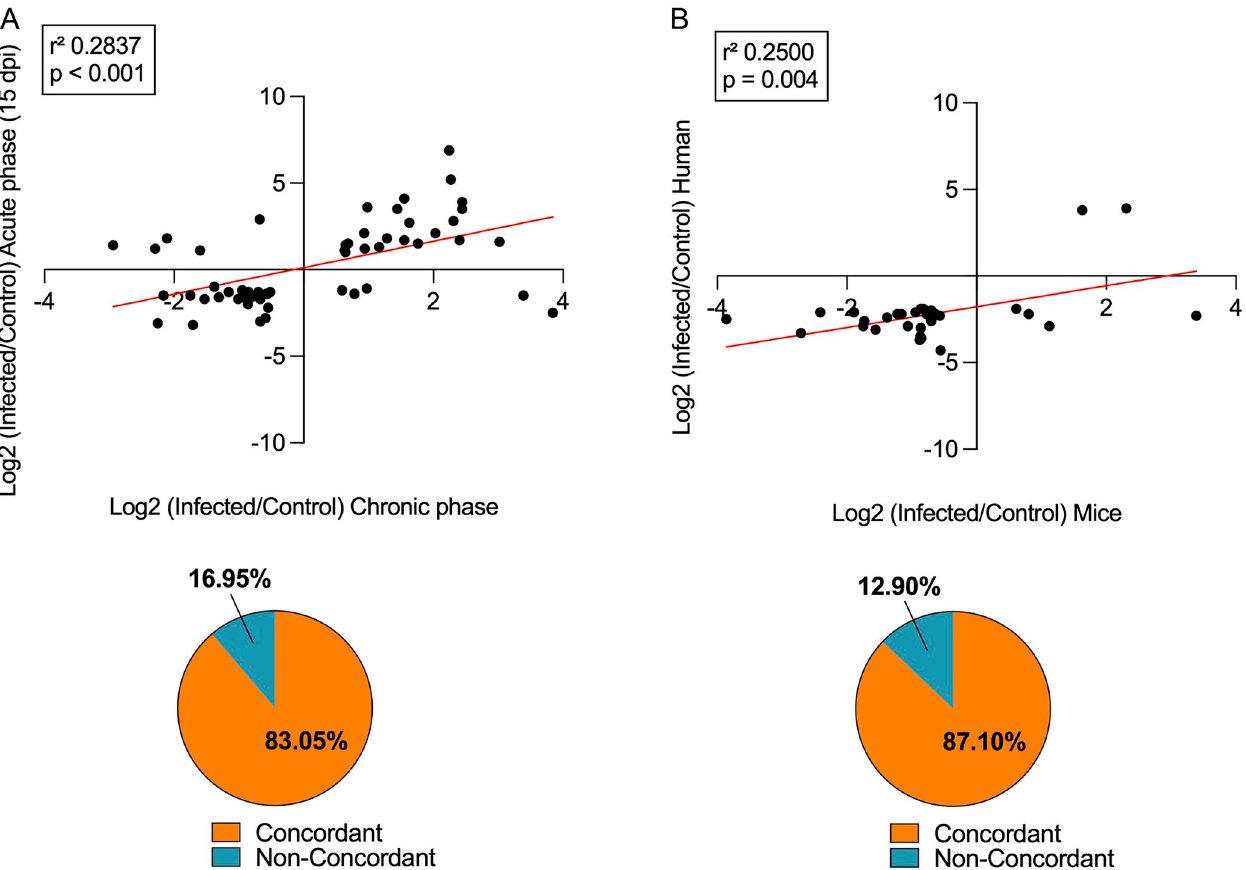
Fig 4. Concordance of miRNA transcriptome with previous studies. (A) Scatter plot of altered miRNAs (1.5-fold change) in mice cardiac tissue in the chronic phase (this study) and in mice cardiac tissue in the acute phase with a pie chart of direction agreements. (B) Scatter plot of altered miRNAs (1.5-fold change) in mice cardiac tissue in the chronic phase (this study) and in cardiac tissue of patients with end-stage CCC with a pie chart of direction agreements.